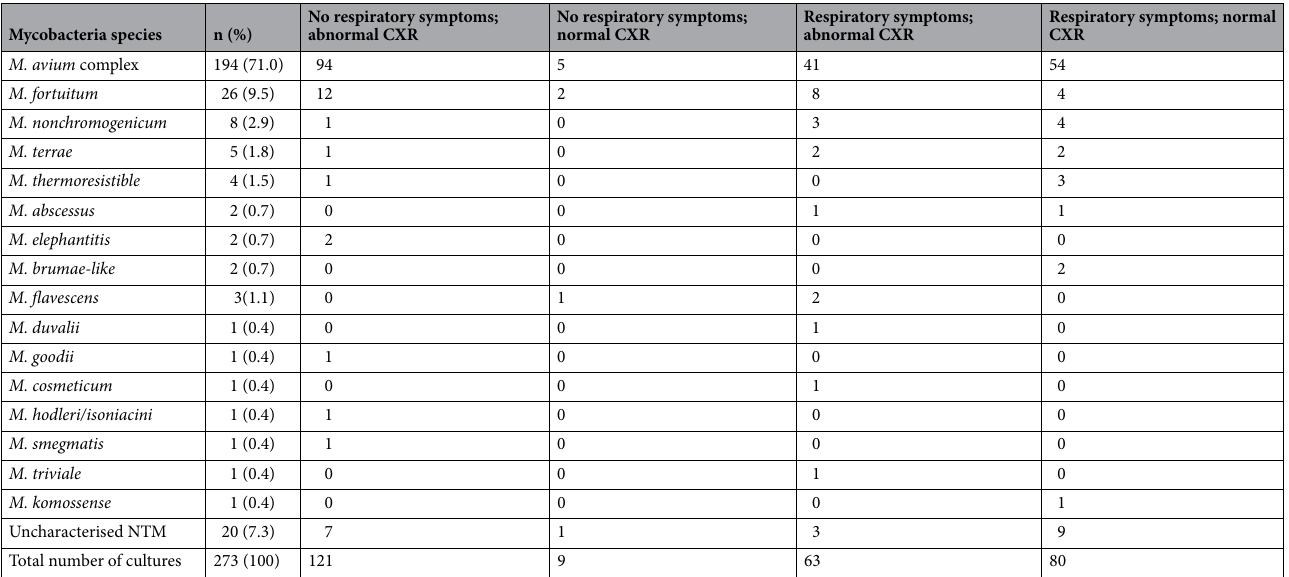
Table 5. The distribution of non-tuberculous mycobacteria species in four participant